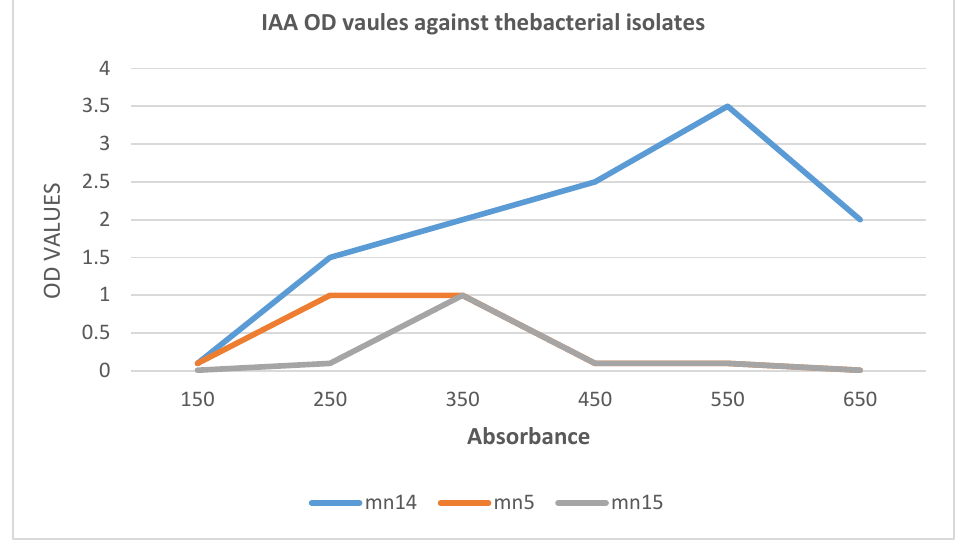
Figure 2. IAA OD values vs. bacterial isolates.